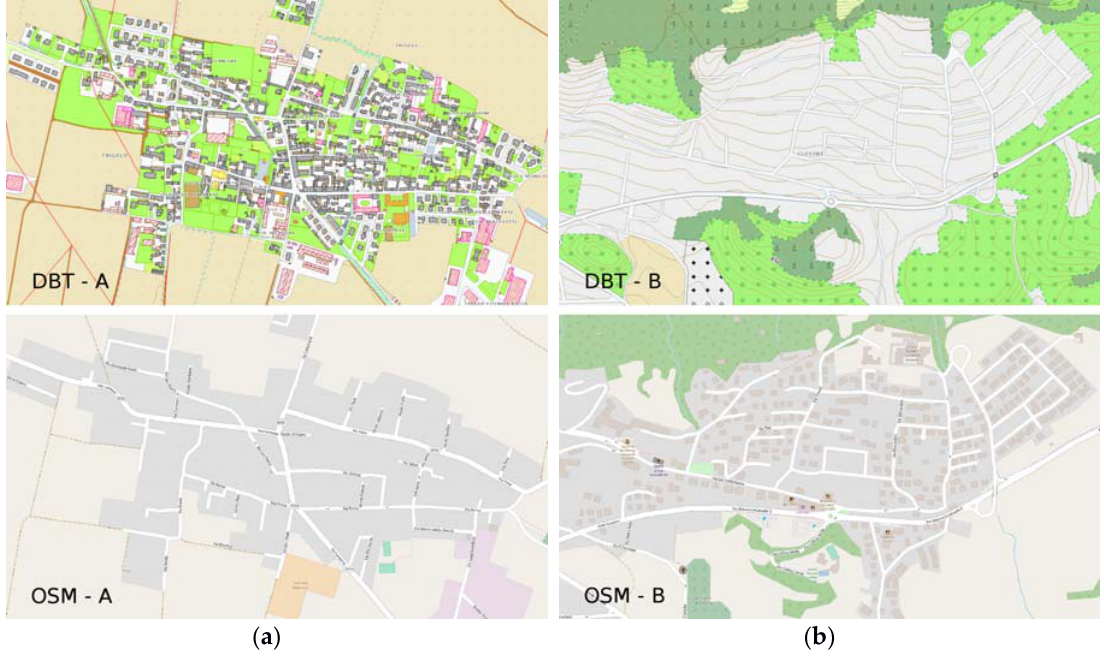
Figure 9. ( a ) Buildings only depicted in the DBT map; ( b ) buildings only depicted in the OSM